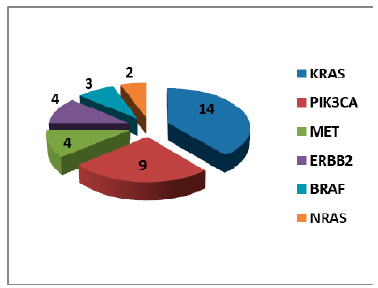
Figure 1. “Other mutations” identified in EGFR-mutant NSCLC cases. Table 2. KRAS-mutant